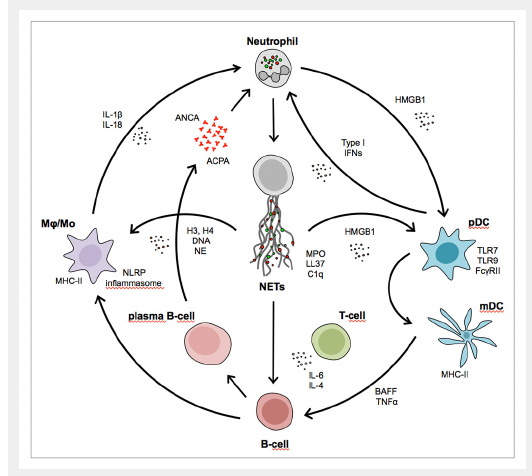
The interactions of pathways and innate and adaptive immune cell types connected with neutrophil extracellular trap formation. ACPA = anti-citrullinated peptide antibody; ANCA = anti-neutrophil cytoplasmic antibody; BAFF = B cell activating factor; FcγRII = Fc gamma receptor II; H3, H4 = histones; HGMB1 = high mobility group box 1 protein; IFN = interferon; IL = interleukin; LL37 = cathelicidin; mDC = myeloid dendritic cell; MHC = major histocompatibility complex; Mϕ/Mo = monocyte subtypes; NE = neutrophil elastase; NET = neutrophil extracellular trap; pDC = plasmacytoid dendritic cells; TLR = Toll-like receptor; TNFα = tumour necrosis factor